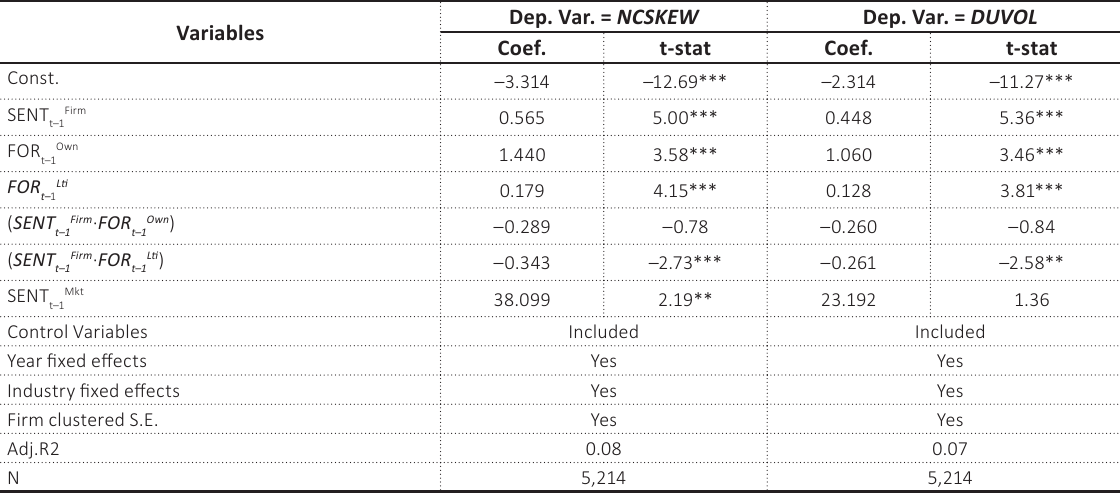
Table 5. Additional test: The effect of foreign ownership and foreign investment